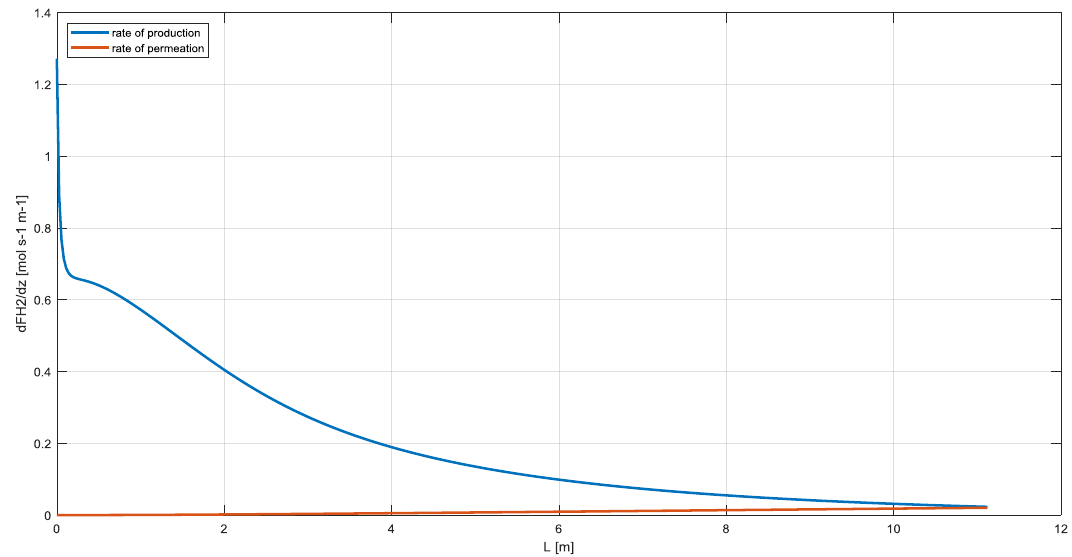
Figure 7. Comparison between the rate of production and rate of permeation of hydrogen in a commercial steam reformer.